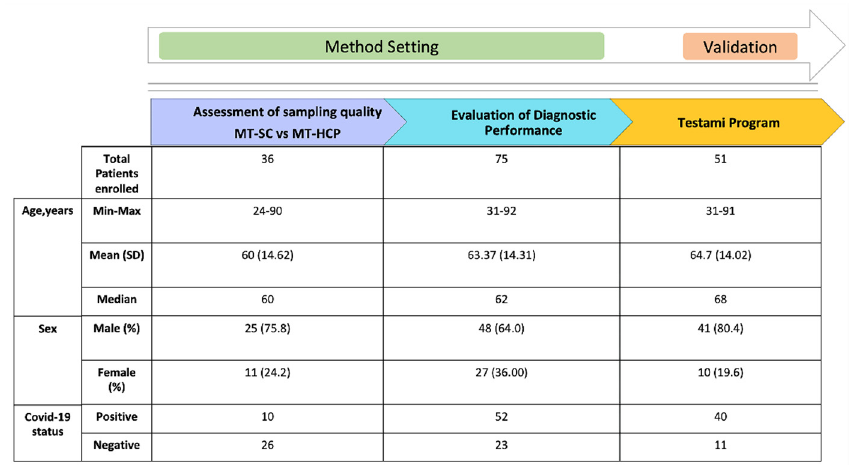
Figure 2. Profile of subjects enrolled for the different phases of the study.